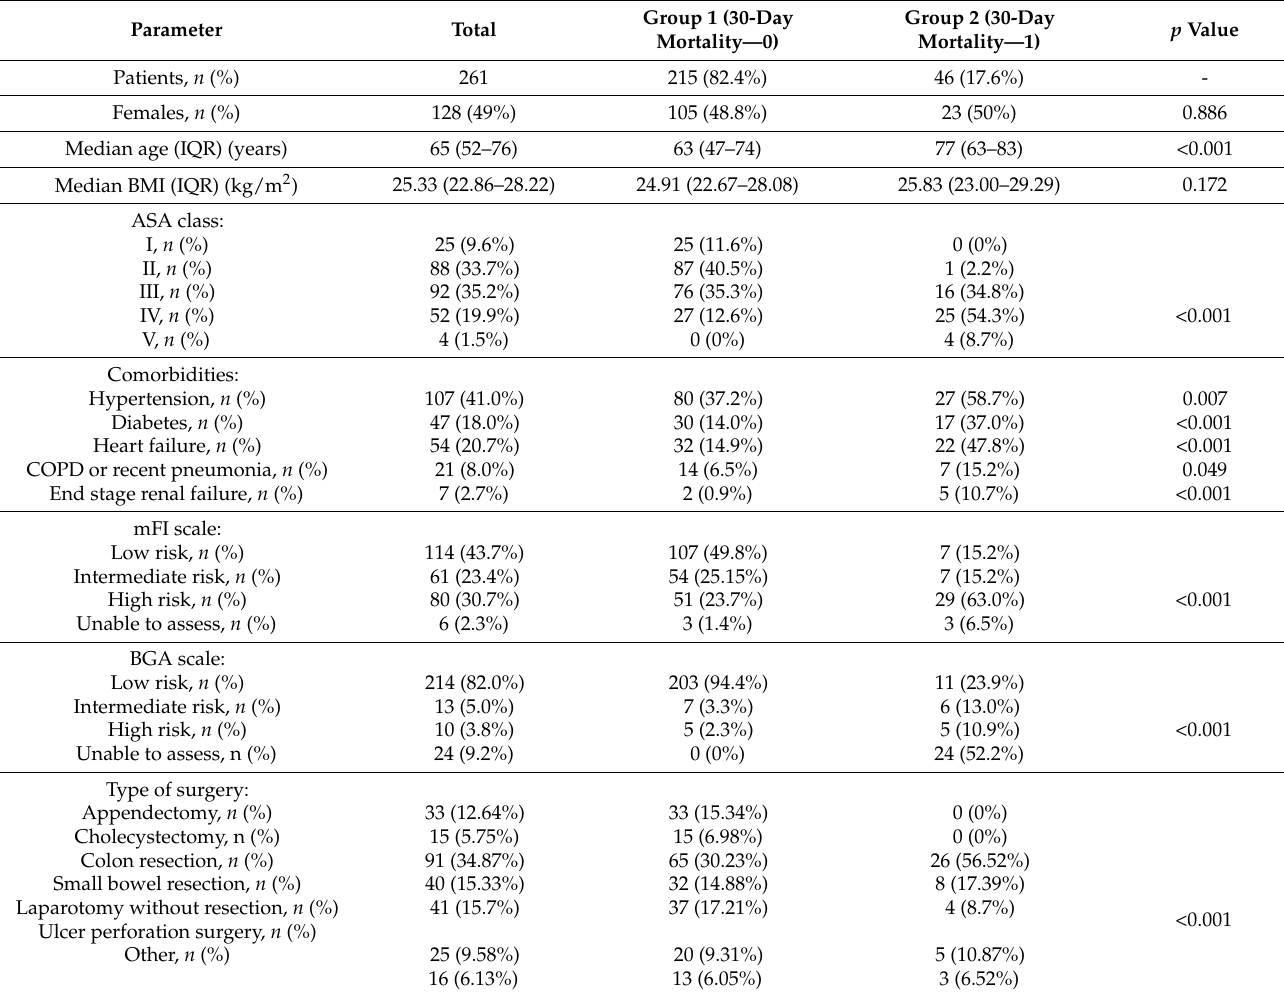
Table 1. Baseline characteristics of study